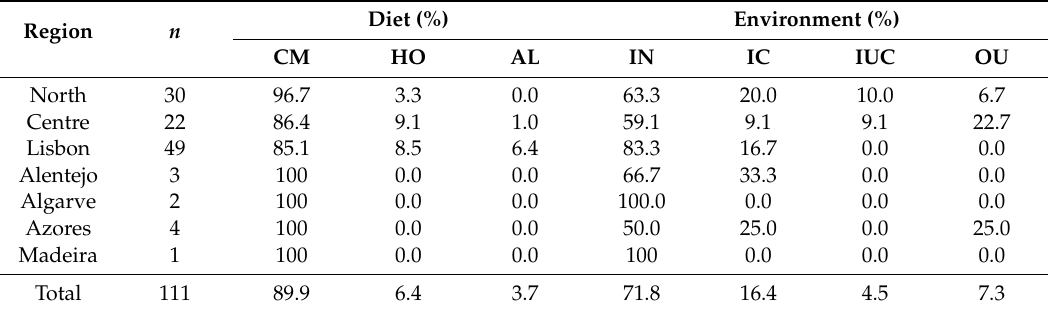
Table 3. Husbandry of Portuguese pets: diet and living